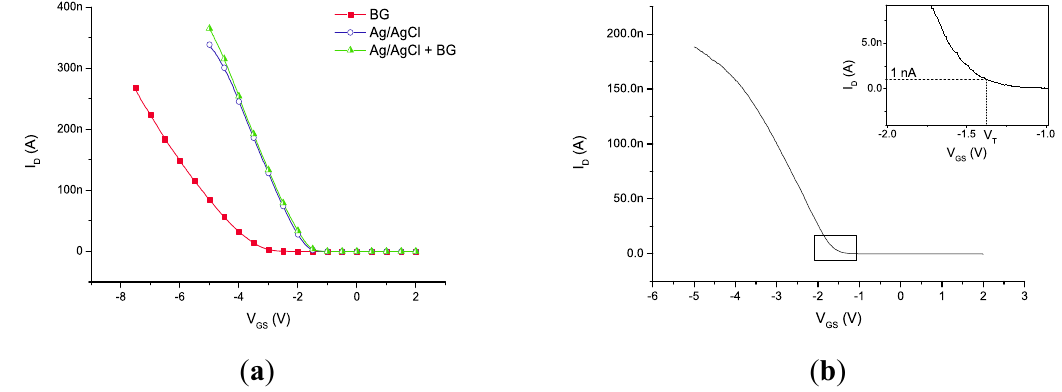
Figure 3. ( a ) I - V characteristics of a device when exposed to water, showing three D GS different types of modes of applying a gate potential. The gate potential was either applied via the back gate without using the liquid gate (red squares), via an Ag/AgCl electrode/liquid gate (blue circles) with the back gate at ground, or via both the back gate and liquid gate via an Ag/AgCl electrode (green triangles); ( b ) Example of the analysis of the curves in de-ionized water (here: liquid-gate swept and back-gate grounded): the ) is the potential at which the current threshold of 1 nA is threshold voltage ( V T